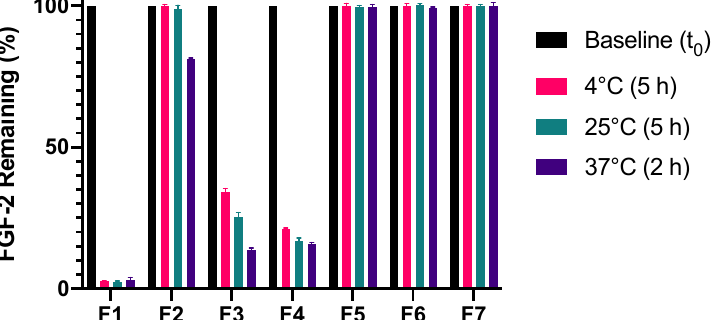
Figure 6. Effect of excipient combinations on the stability of FGF-2 aqueous solutions (770 ng/mL) incubated at 4 °C for 5 h, 25 °C for 5 h and 37 °C for 2 h. Residual FGF-2 content following incubation was measured by ELISA and expressed as a percentage of the baseline concentration (mean ± SD, n = 3). Abbreviations of samples: F1, FGF-2 in water; F2, FGF-2 and 0.05% w/v methylcellulose (MC) in water; F5, FGF-2, 0.05% w/v MC and 20 mM alanine in water; F6, FGF-2, 0.05% w/v MC and 1 mg/mL human serum albumin (HSA) in water; and F7, FGF-2, 0.05% w/v MC, 20 mM alanine and 1 mg/mL HSA in water.